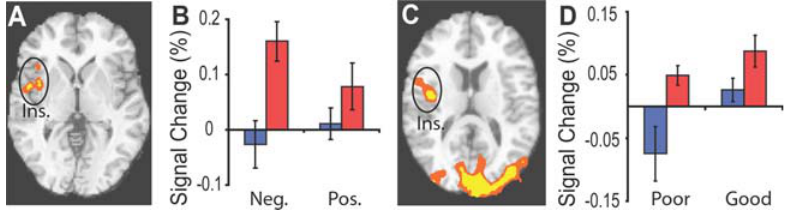
Figure 2. Meditation modulates right insula response to emotional sounds: A. Voxel-wise analysis of the Group by State by Valence (negative versus positive sounds) interaction in insula (Ins.) (z=2, corrected, colors code: orange, p , 5.10ˆ-2, yellow, p , 2.10ˆ-2, 15 experts (red) and 15 novices (blue)). B. Average response in Ins. from rest to compassion for experts (red) and novices (blue) for negative and positive sounds. C–D. Voxel-wise analysis of BOLD response to emotional sounds during during poor vs. good blocks of compassion, as verbally reported. C. Main effect for verbal report in insula (Ins.) (z=13, corrected, colors: orange, p , 10ˆ-3, yellow, p , 5.10ˆ-4, 12 experts and 10 novices). D. Average response in (Ins.) for experts (red) and novices